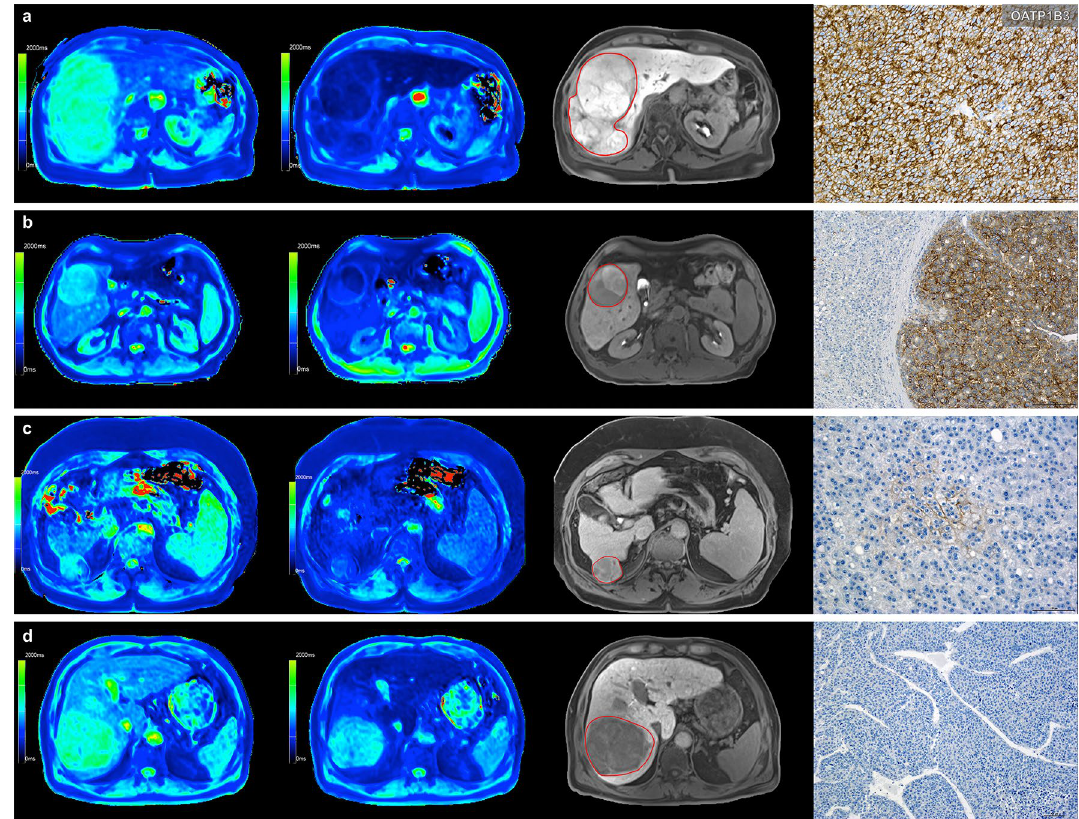
Figure 2. Comparison of T1 maps acquired with a variable-flip-angle MR sequence before (1st column) and 20 min after (2nd column) the administration of Gd-EOB-DTPA for HCCs (A-D) with differential OATP1B3 expression (4th column, immunostaining OATP1B3). The 3rd column displays the corresponding T1-weighted VIBE sequence with fat suppression in the hepatobiliary phase. All images displayed were taken with the same window and center level. The scale on the histopathology images represents 500 μm. ( a ) Well- differentiated HCC with high OATP1B3 expression on all tumor cells (score 12); the HCC and the surrounding liver parenchyma (normal liver parenchyma) showed high uptake of Gd-EOB-DTPA, with a reduction rate of 0.59 within the tumor. ( b ) Well-differentiated HCC with heterogeneous OATP1B3 expression: high OATP1B3 expression on the right side and low expression on the left side on tumor cells (score 6); the split within the tumor can be clearly visualized on the MR image; the T1 reduction rate was 0.49 for the HCC. ( c ) Well- differentiated HCC with minimal OATP1B3 expression on only a few tumor cells (score 1); heterogeneous uptake is also visible on the MR images, resulting in a tumor reduction rate of 0.22. ( d ) Poorly differentiated (macrotrabecular subtype) HCC with no OATP1B3 expression on tumor cells (score 0). By comparing the plain and enhanced images, only a few changes can be noticed, with a tumor reduction rate of